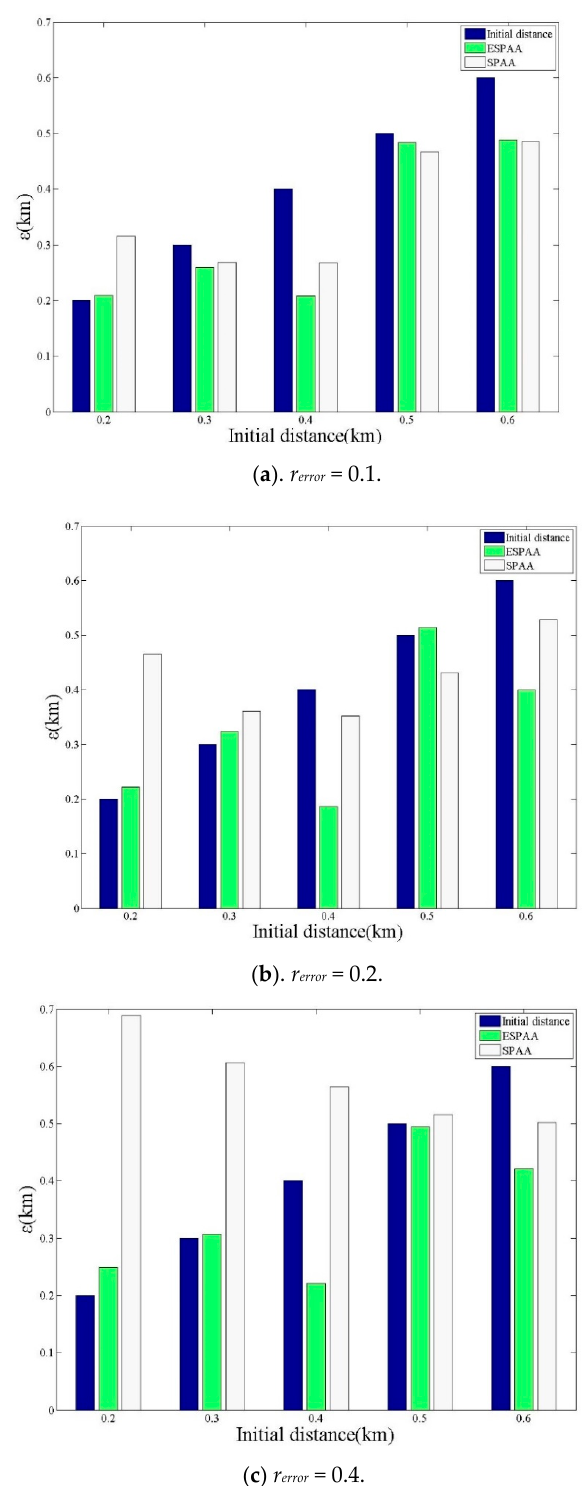
Figure 10. The effect of different r error on positioning errors ( a ) r error = 0.1 ( b ) r error = 0.2 ( c ) r error = 0.4. Figure 10. The e ff ect of di ff erent r